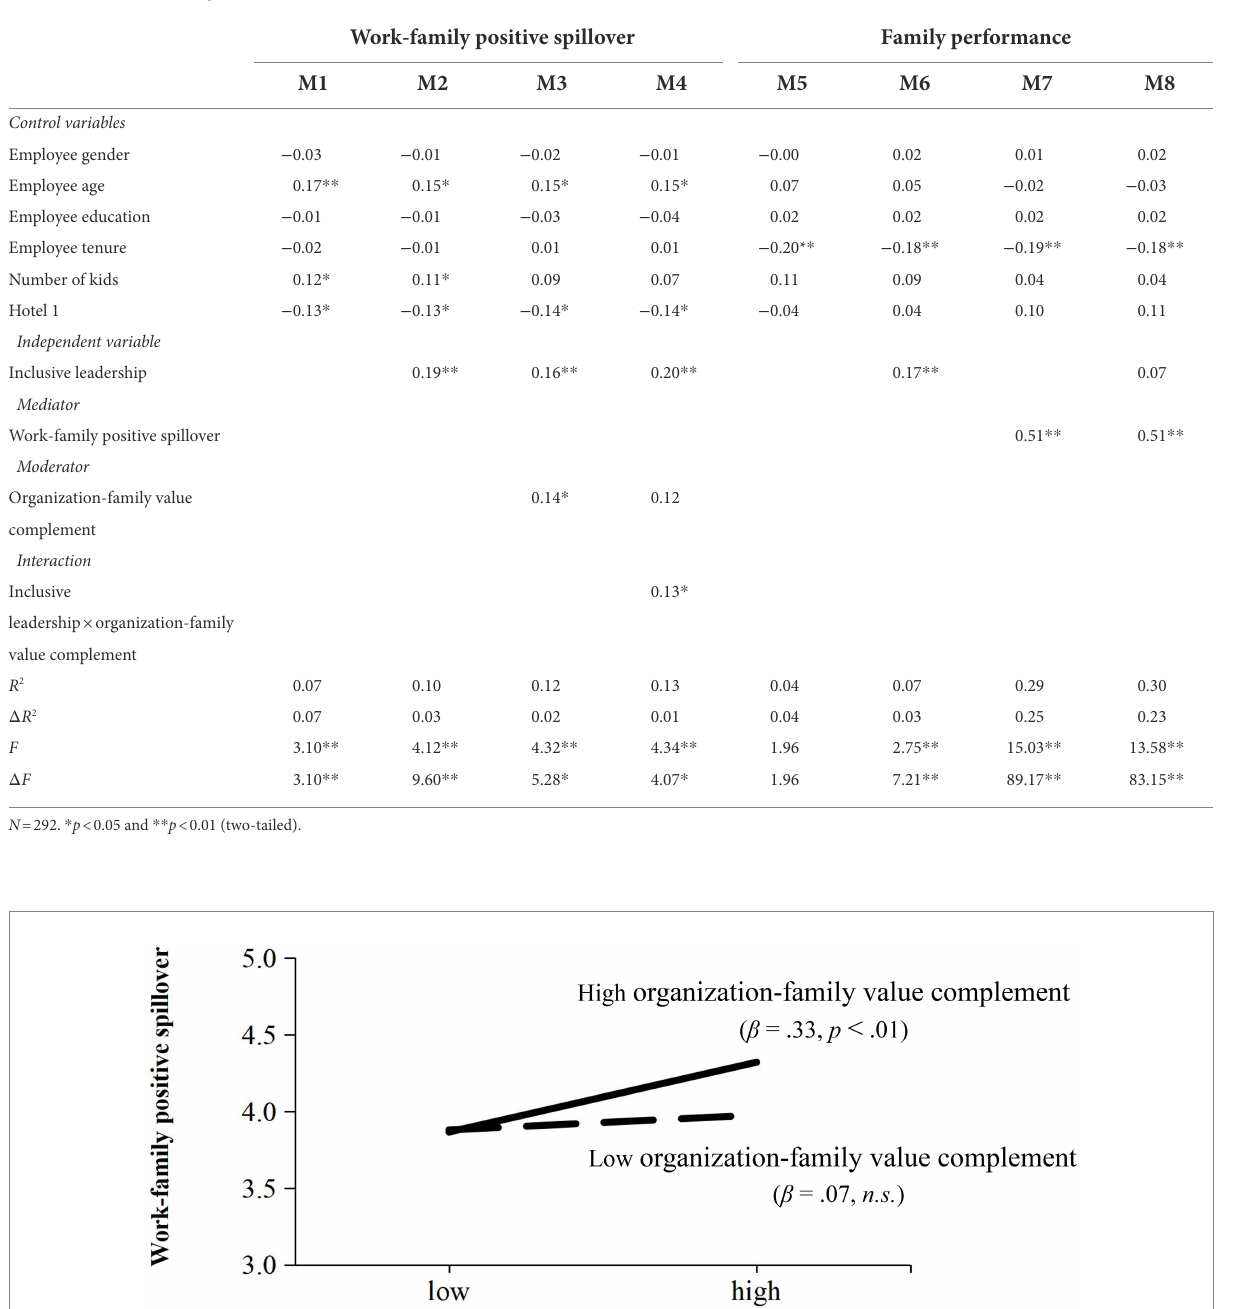
TABLE 3 Hierarchal analysis results.